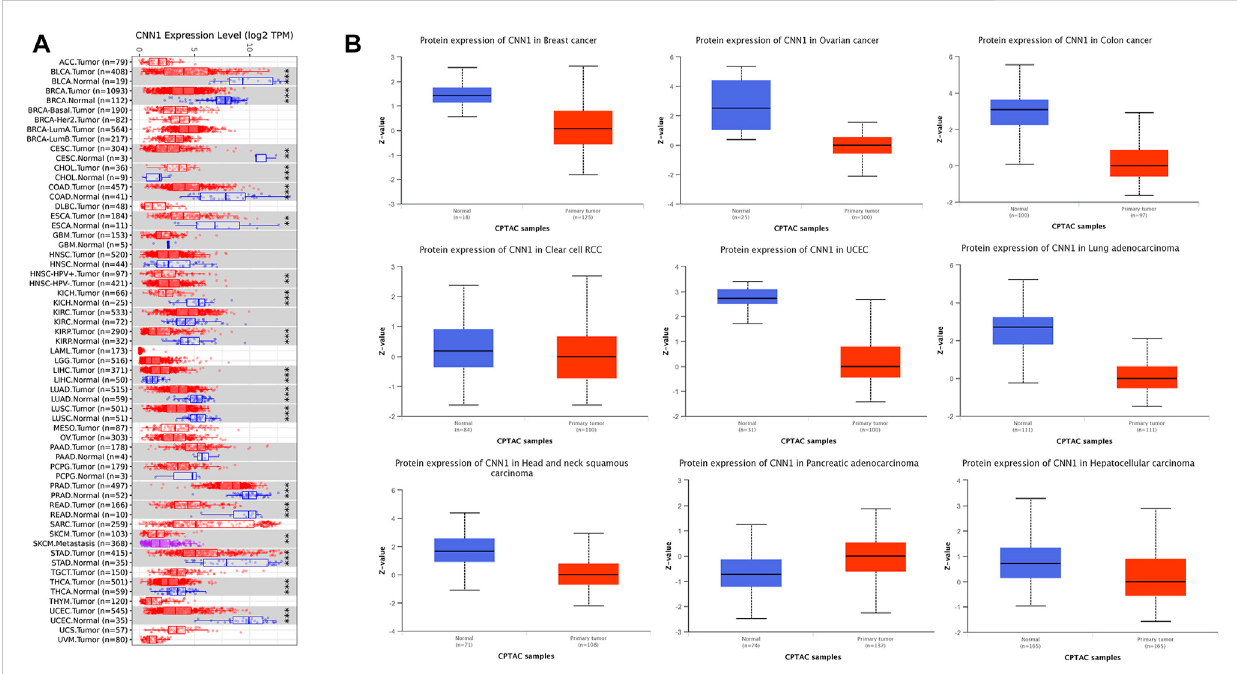
FIGURE 1 Analysis of CNN1 expression levels in human pan-cancer samples. (A) Expression levels of CNN1 in different cancer types in the TCGA database analyzed using the TIMER database (* p < 0.05, ** p < 0.01, and *** p < 0.001). (B) Differences in CNN1 expression between tumor and paracancerous tissues in the CPTAC